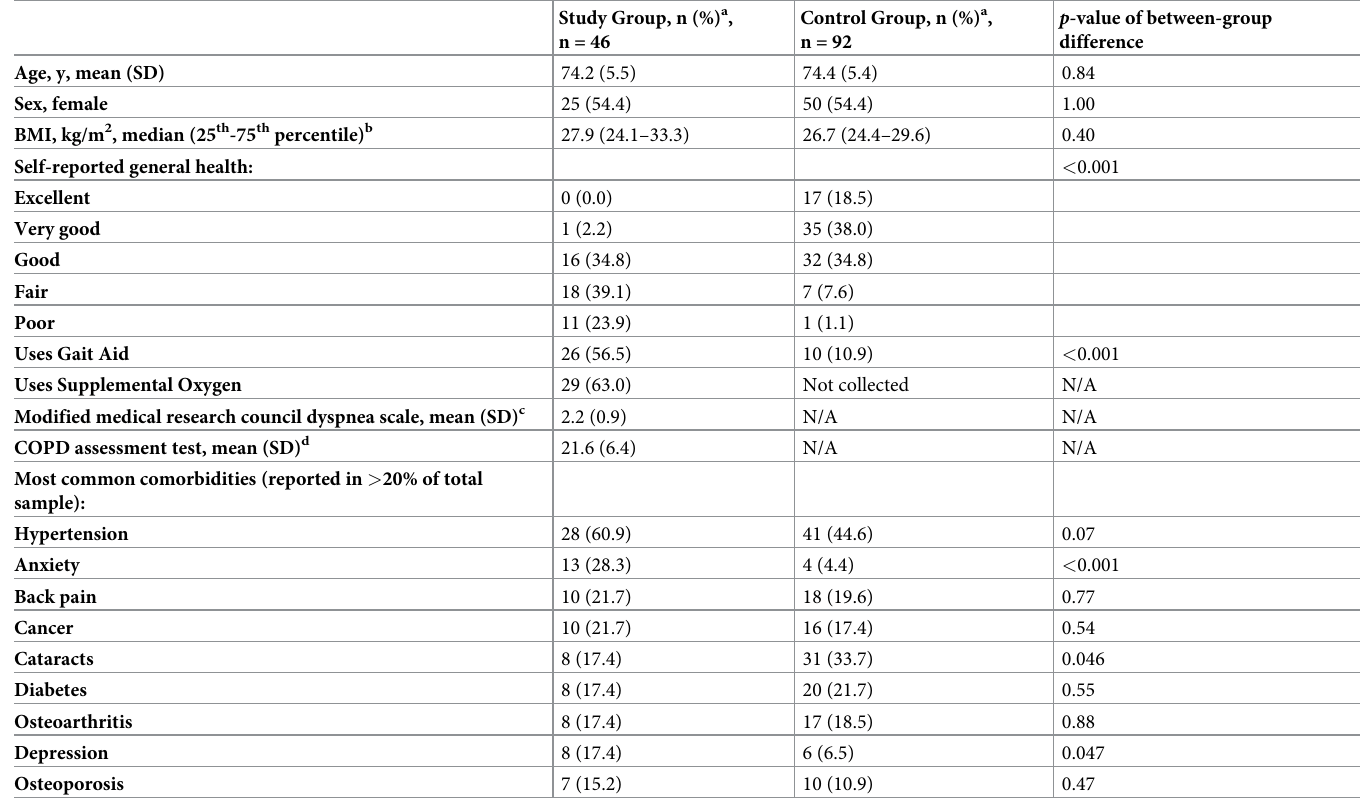
Table 1. Participant